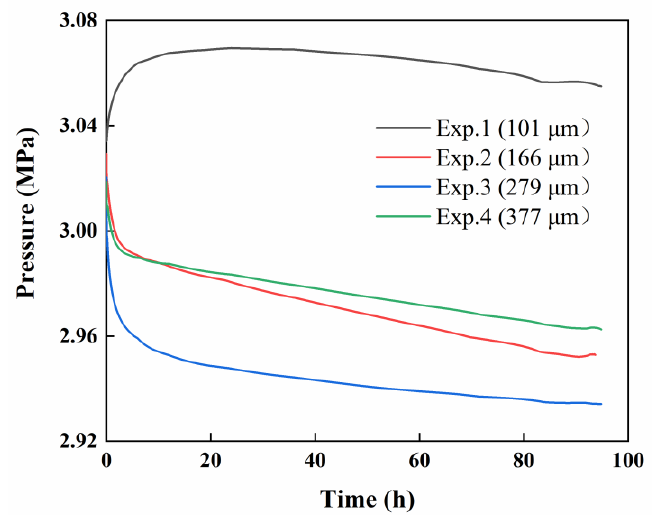
Figure 3. Variation in pressure with time during the replacement process for Experiments 1, 2, 3, and 4.